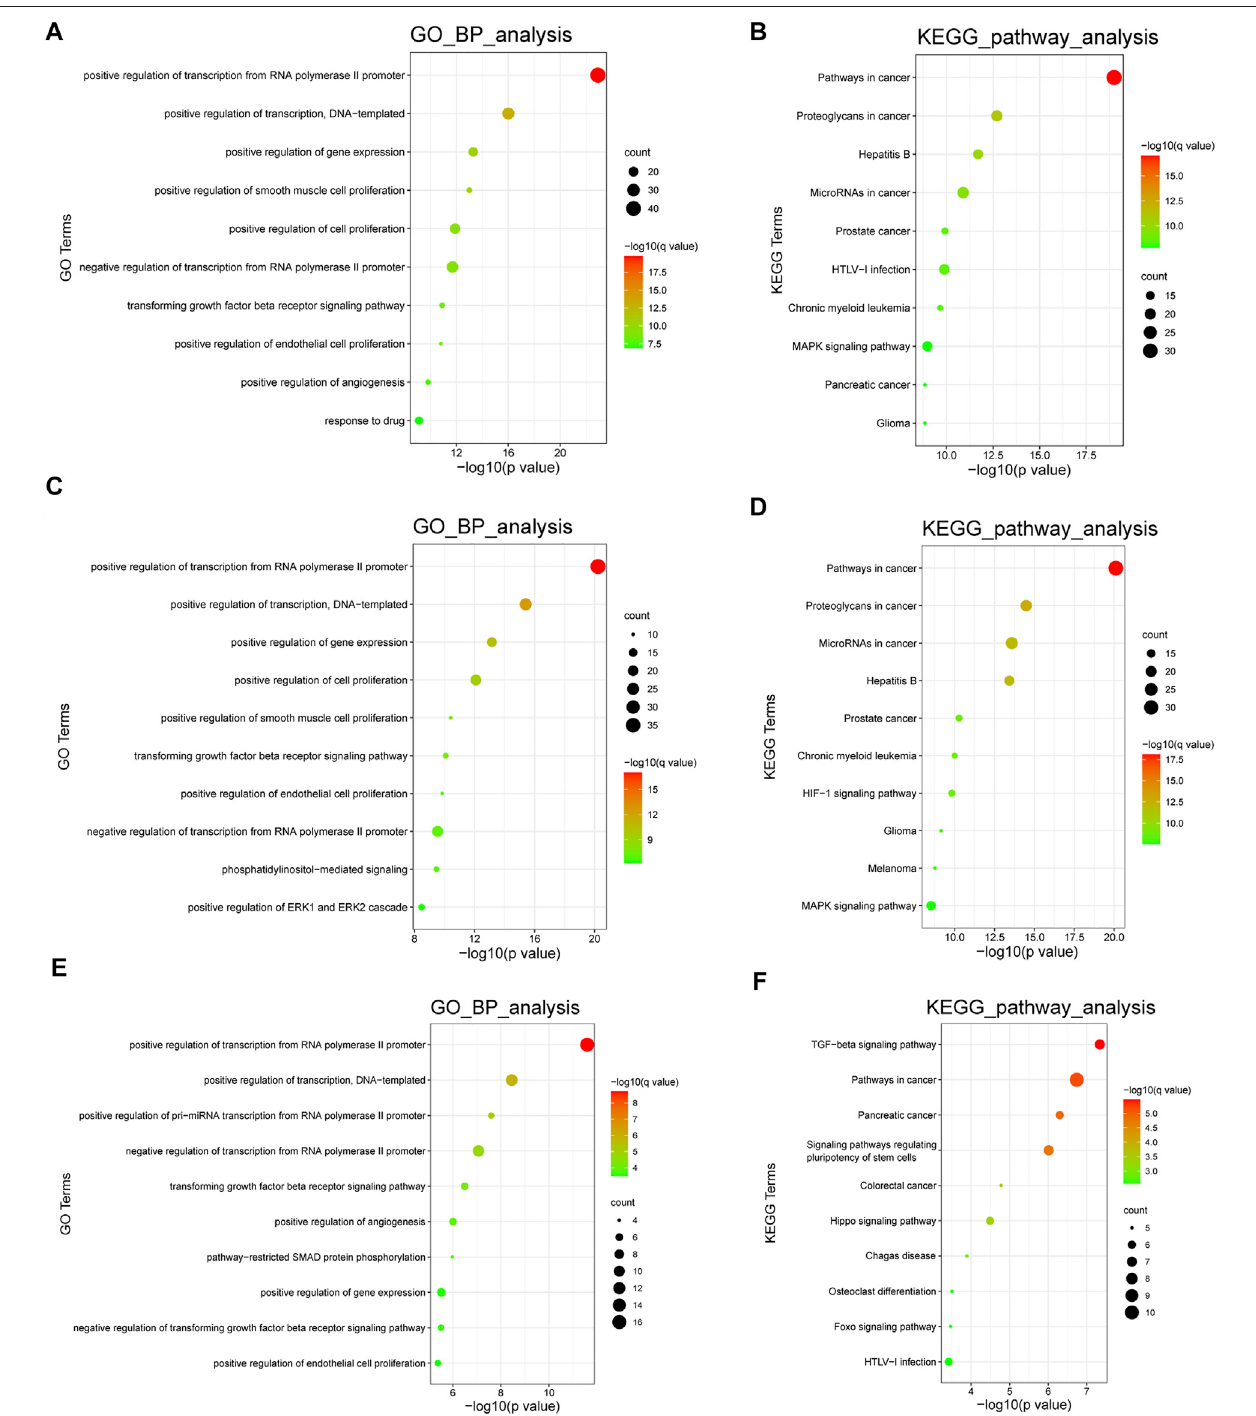
FIGURE 6 | Functional analyses of the ncRNAs. (A,B) . The top 10 enriched GO biological process terms and KEGG pathways in all cell types. (C,D) The top 10 enriched GO biological process terms and KEGG pathways in PASMCs. (E,F) The top 10 enriched GO biological process terms and KEGG pathways in PAECs. Node sizes indicate the number of genes enriched in functional clusters. Node colors are related to q values. GO: gene ontology; KEGG: Kyoto Encyclopedia of Genes and Genomes.